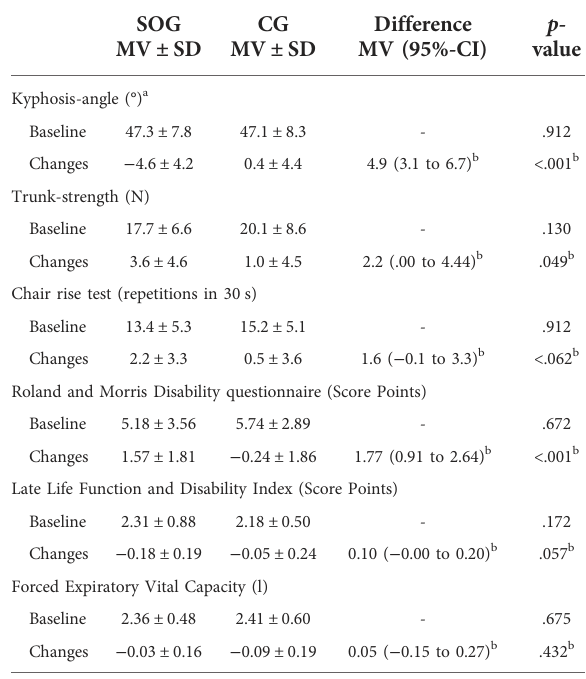
TABLE 2 Baseline values and changes of back pain intensity (primary outcome) and pain medication (explanatory outcome) of the spinal orthosis (SOG) and control group